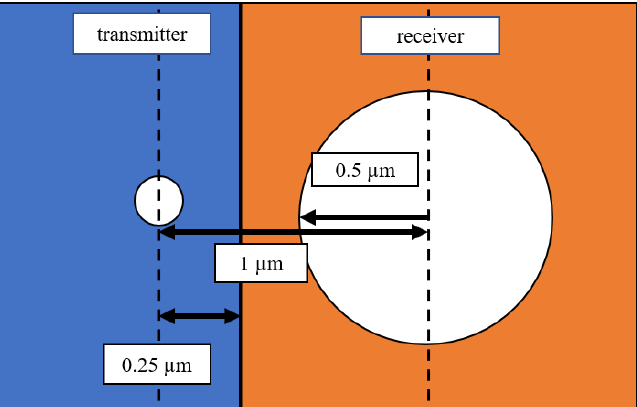
Figure 4. System model with heterogeneous temperature